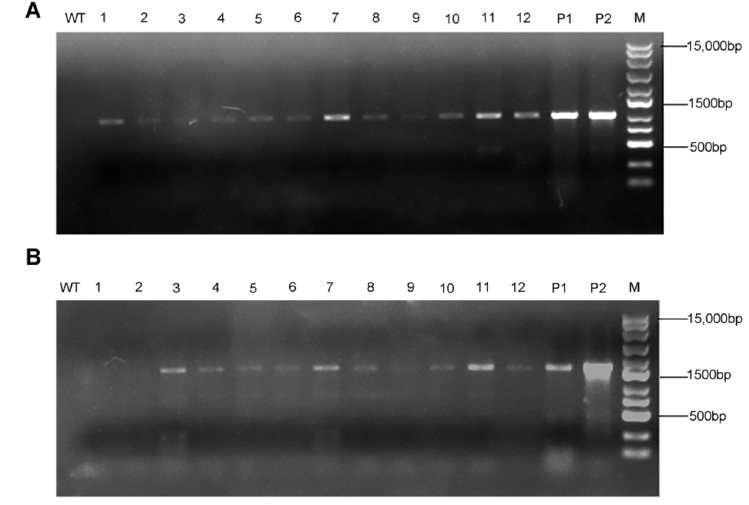
Figure 2. Molecular identification of transgenic alfalfa. ( A ) PCR amplification of Hyg in transgenic alfalfa. ( B ) PCR amplification of ScABI3 in transgenic alfalfa. M: 15,000 bp Molecular weight marker. P1, P2: 35S::ScABI3-pCAMBIA1301 (Positive control). WT: wild-type alfalfa. 1–12: transgenic alfalfa.